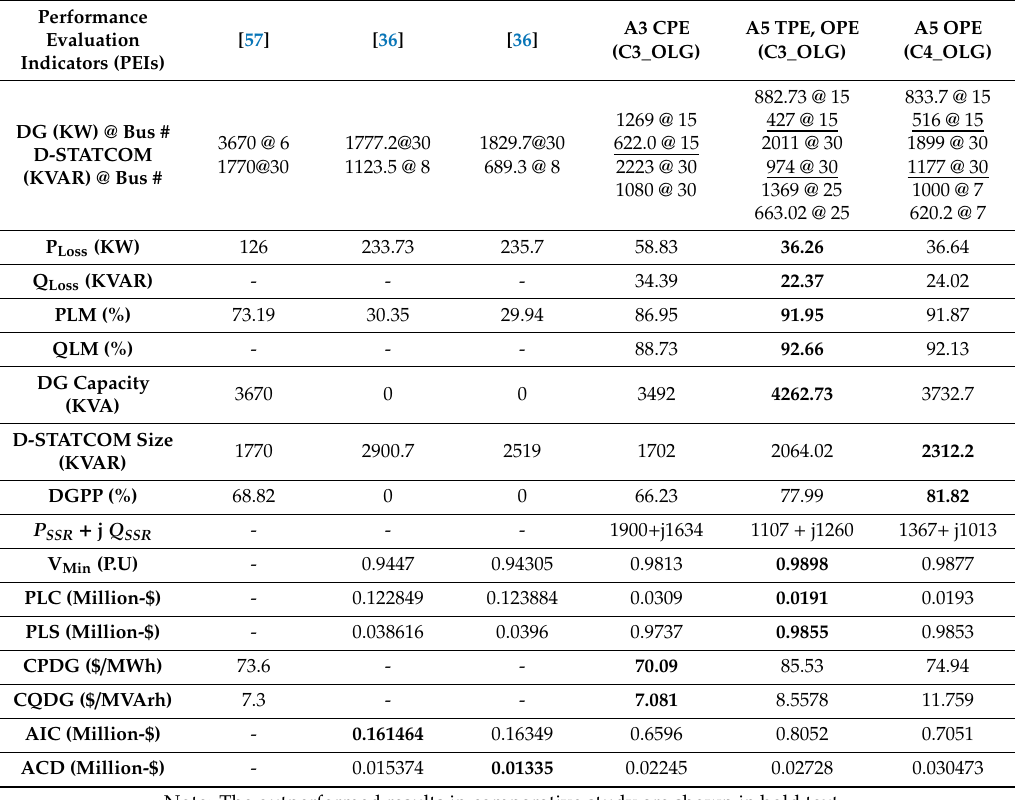
Table 37. Comparisons of results with C4-C4 under OLG for 33-bus TDS (REG +